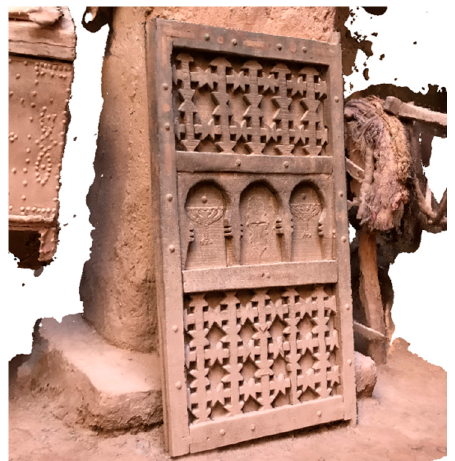
Figure 27. 3D model of a wooden carved artifact (Kasbah des Caids, Tamnougalt), photographed by iPhone 7 (5 min, 36 images from a distance 1–1.5 m). In this case, the created model using close-range photogrammetry was very good.